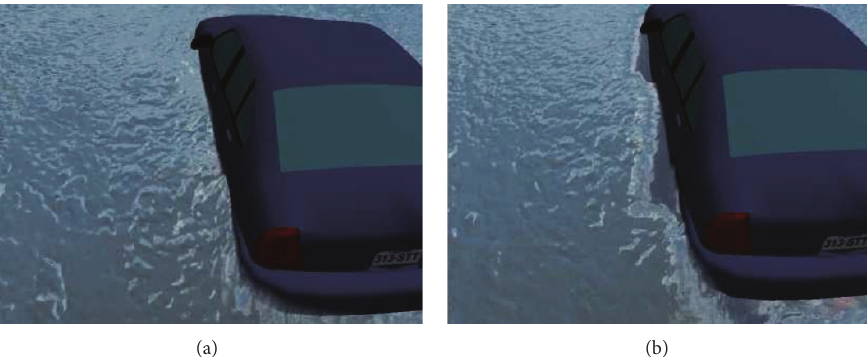
Figure 6: (a) Using the effective surface results in a flawless water-object border. (b) Dents and grid artifacts are visible when the surface pushed down by the car is